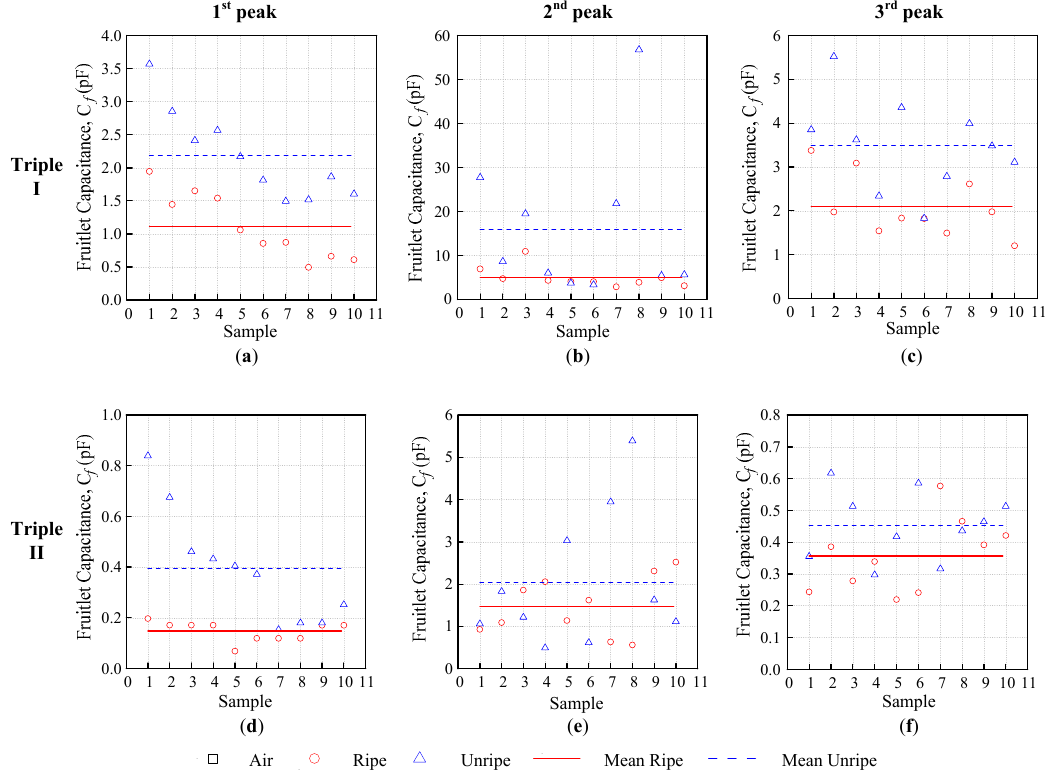
Figure 13. Ripe-unripe first, second, and third fruitlet capacitance comparison for Triple I: ( a – c ) and Triple II: ( d – f ).